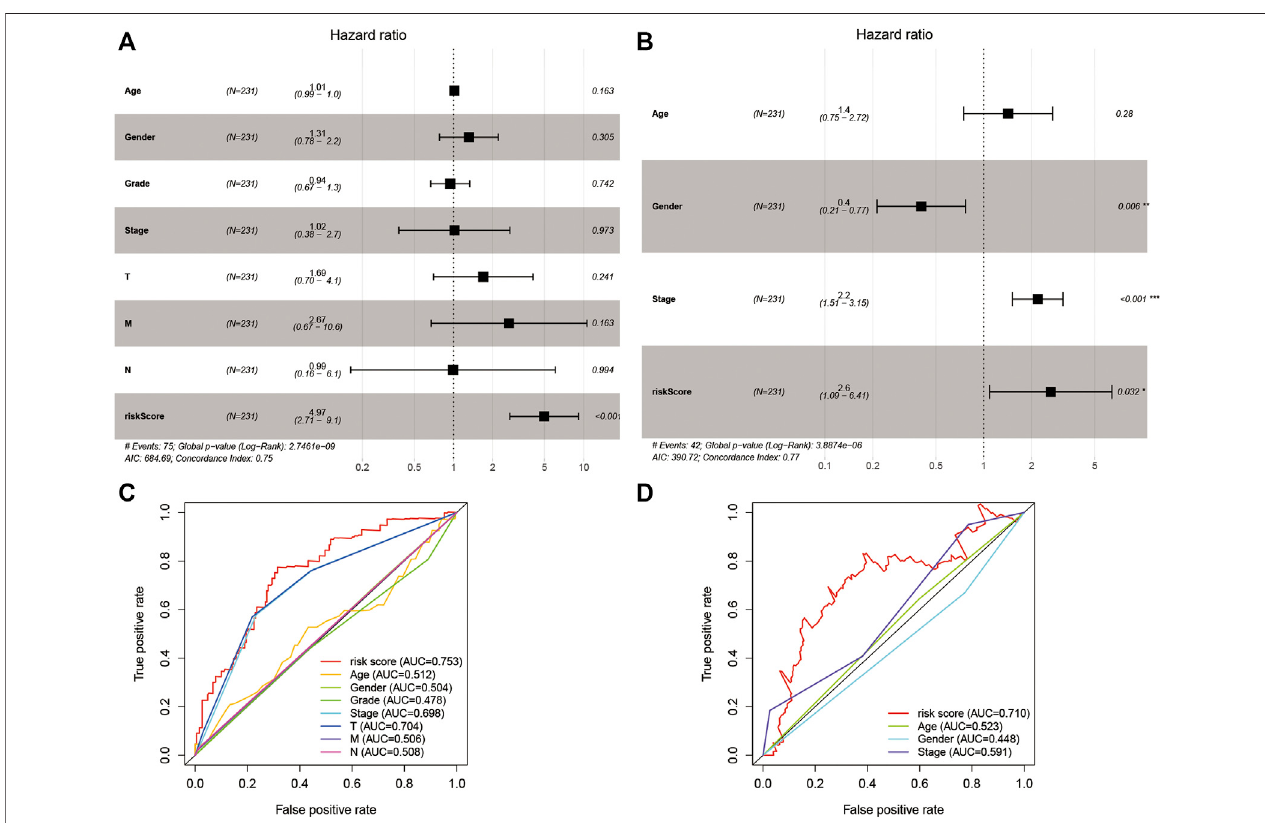
FIGURE 5 | The results of the multivariate Cox regression analysis and the ROC analysis of the 9-gene signature risk score. (A,B) Multivariate Cox regression analysis including the 9-gene signature risk score and clinical features in the TCGA cohort and ICGC cohort based on OS. (C,D) ROC analysis based on the risk score and other clinical features. HR, hazard ratio. CI, con fi dence